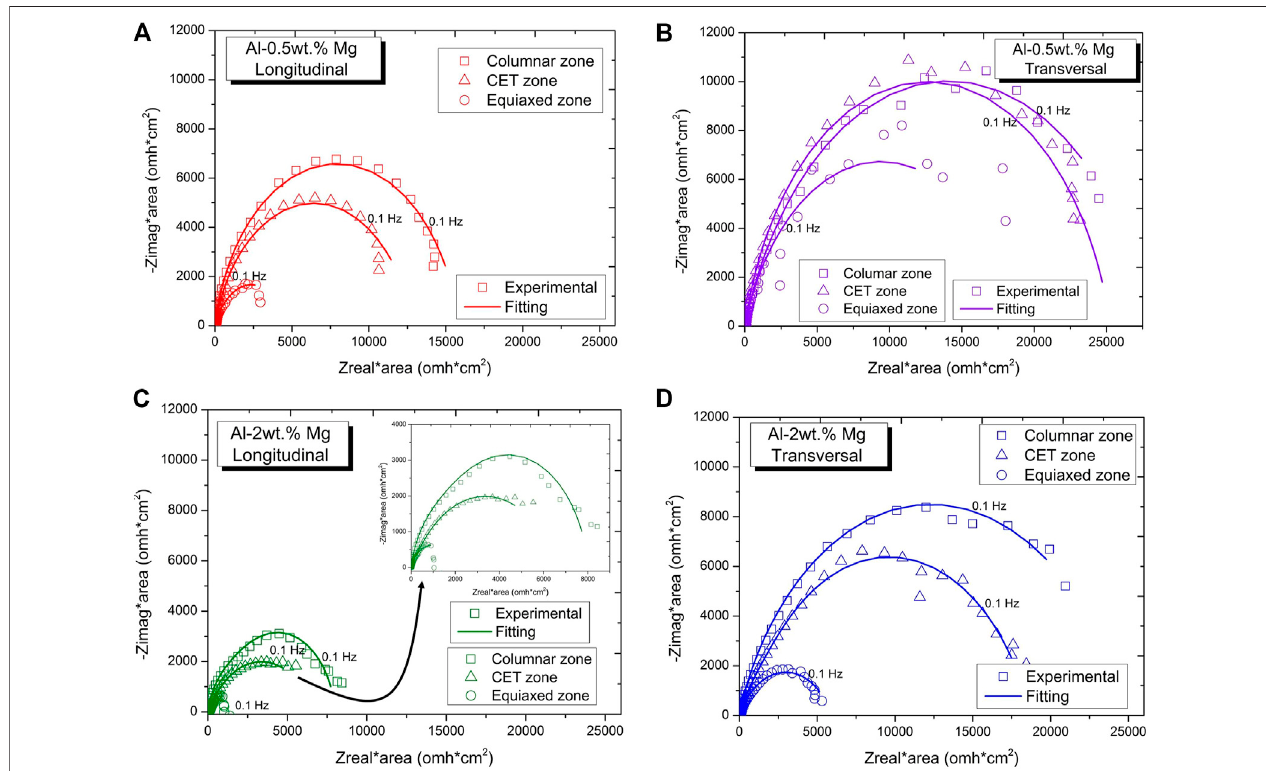
FIGURE 8 | Nyquist diagrams of Al-Mg alloys. (A) Al-0.5wt.% Mg alloy (longitudinal). (B) Al-0.5wt.% Mg alloy (transversal). (C) Al-2wt.%Mg alloy (longitudinal). (D) Al-2wt.%Mg (transversal)